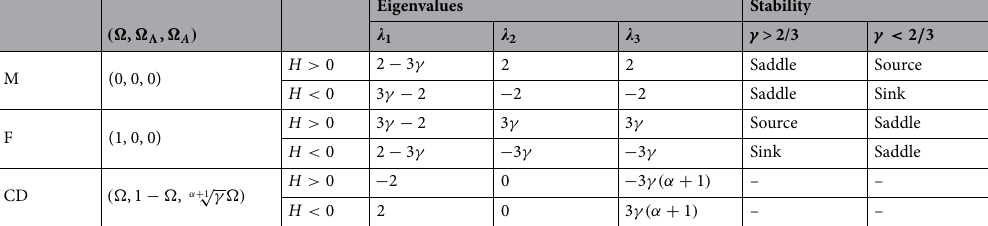
Table 1. Properties of the equilibrium points for k = 0,